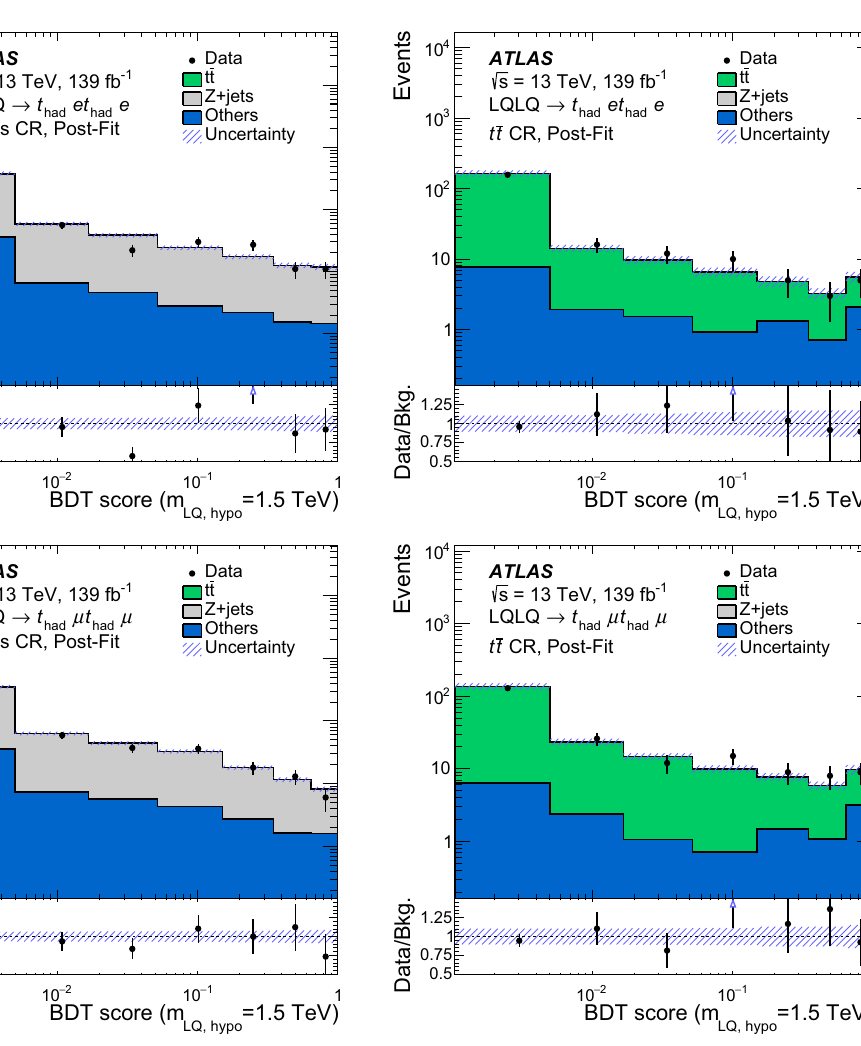
Fig. 3 Distributions of the BDT output score in the Z + jets and t ¯ t CRs for the electron (top row) and muon (bottom row) channel after the simultaneous background-only fit of the CRs. The bottom panels show the ratio of data to expected background. The hatched band rep-